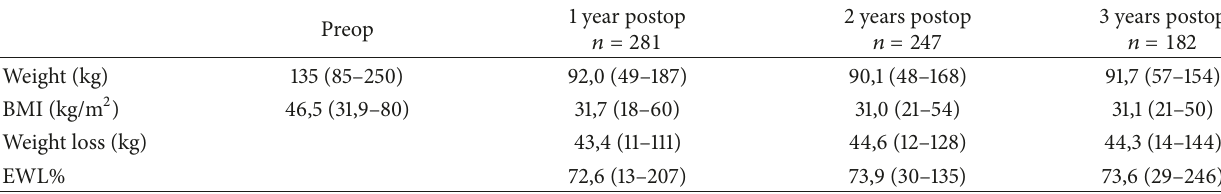
Table 2: Weight loss outcomes. Data are expressed as mean (range).